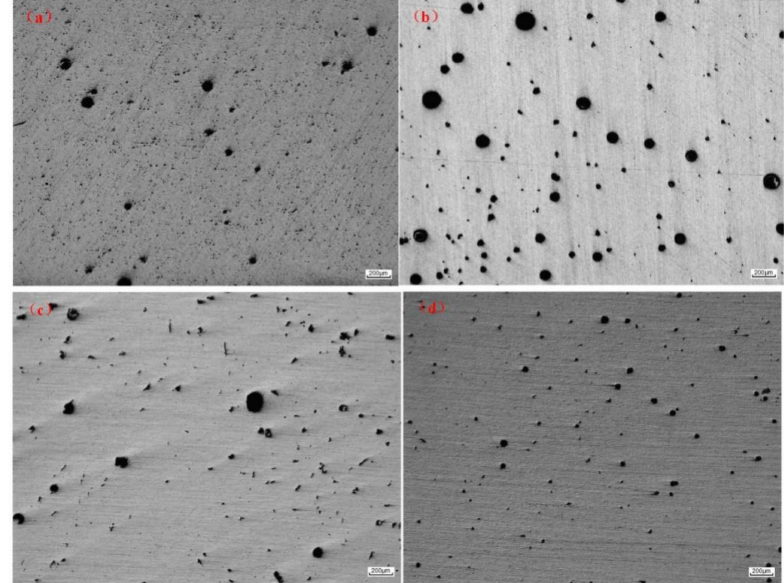
Figure 5. Optically observed porosity for the WAAM 2219 aluminum alloys by different modes: